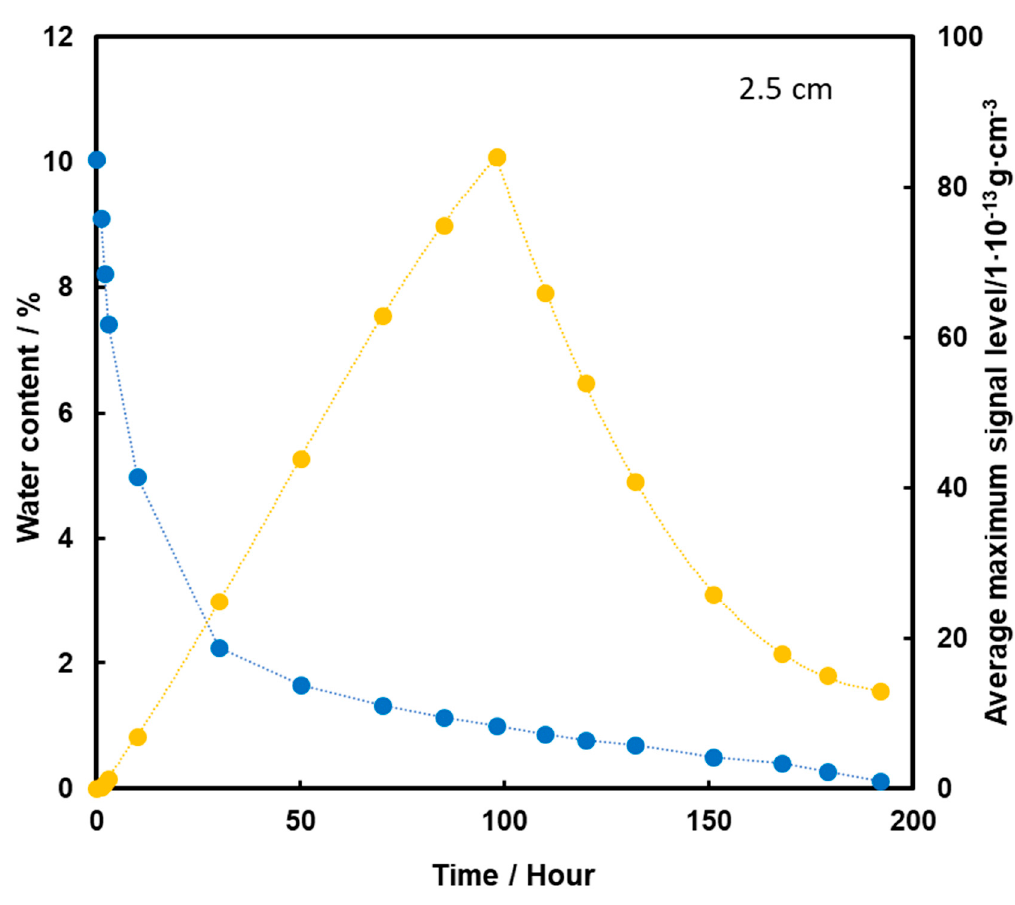
Figure 9. Dependence of the mean maximum TNT signal ( ● ) on the amount of water ( ● ) in the substrate for the TNT sample at a depth of 2.5 cm, at a temperature of 50 °C.